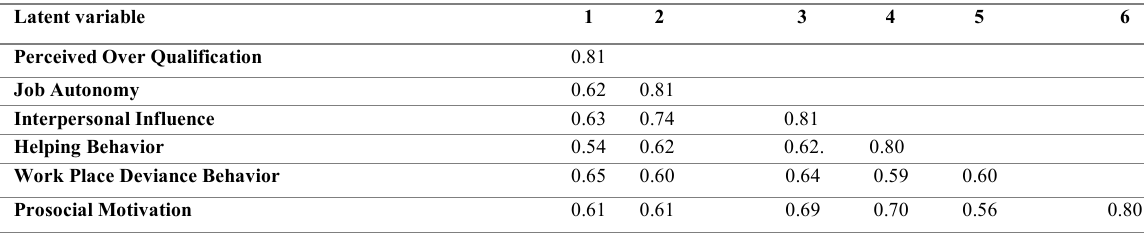
Table 2 : Correlation matrix with square root of AVE at